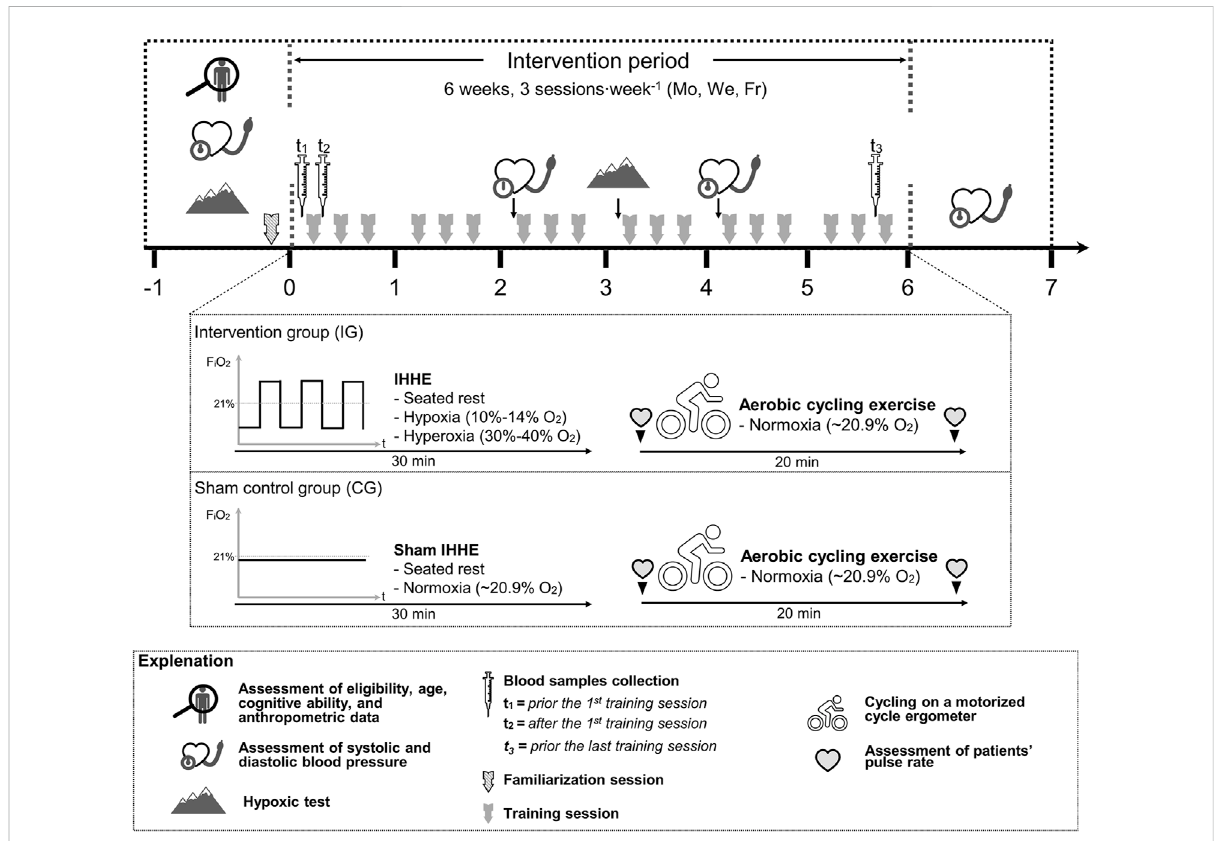
FIGURE 1 Study design and schematic overview of the interventions. F i O 2 , fraction of inspired oxygen; Fr, Friday; IHHE, intermittent hypoxic-hyperoxic exposure; Mo, Monday; We,